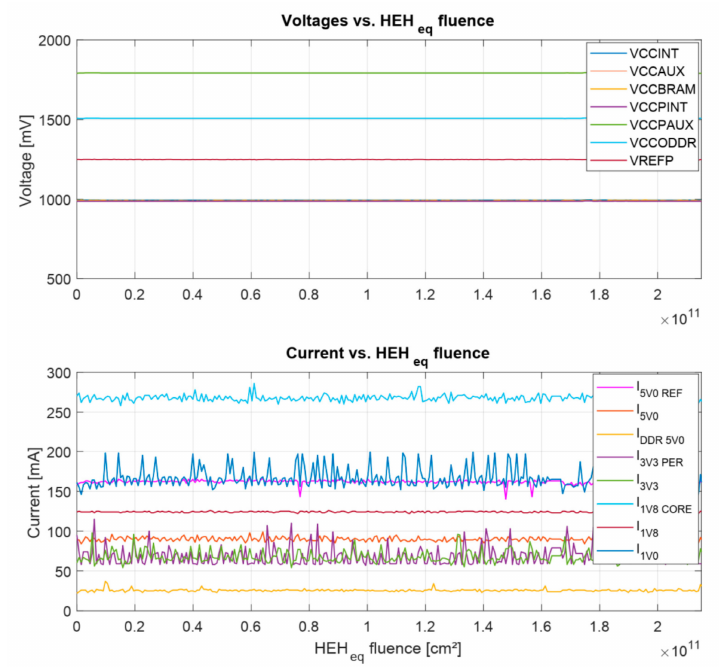
Figure 7. Monitored internal voltages ( top ) and currents ( bottom ) during irradiation of SUT#1.